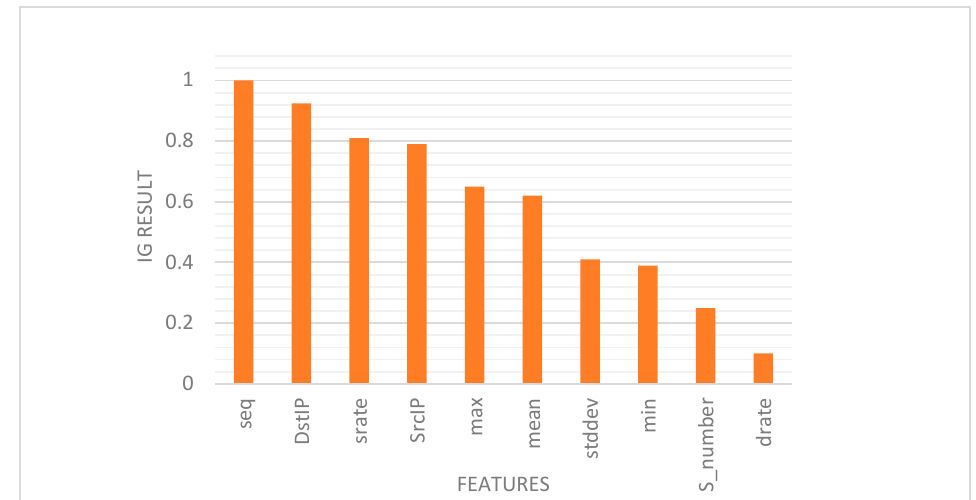
Figure 5. Feature ranking based on information gain.